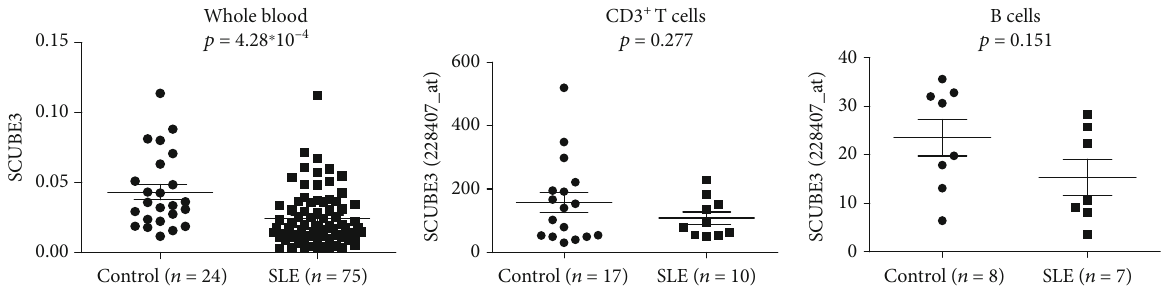
Control ( n = Figure 2: Low expression of SCUBE3 in SLE patients. The levels of SCUBE3 mRNA expression in whole blood from our lab and in CD3 T cells (E-GEOD-13887) and B cells (E-GEOD-4588) from the ArrayExpress